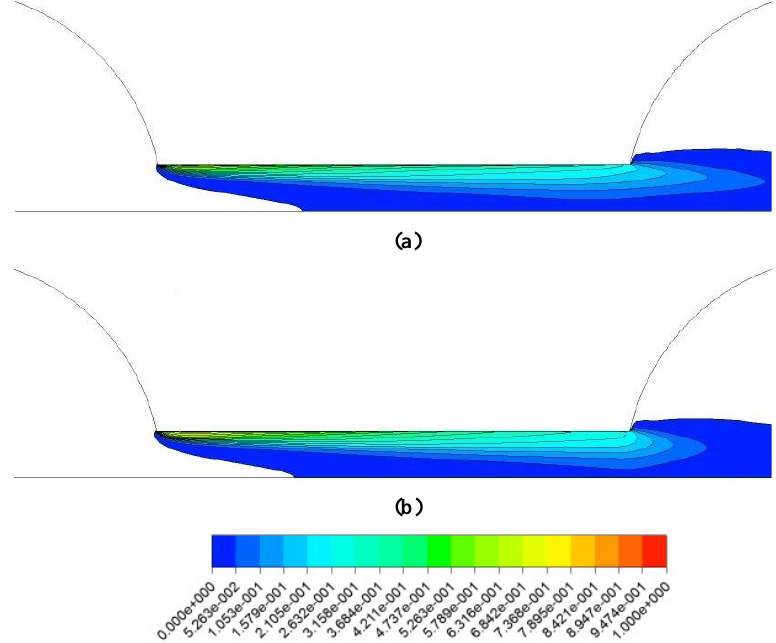
Figure 10. Visual comparison of vapor volume fraction predicted using two cavitation models; ( a ) SS model, ( b ) ZGB model.